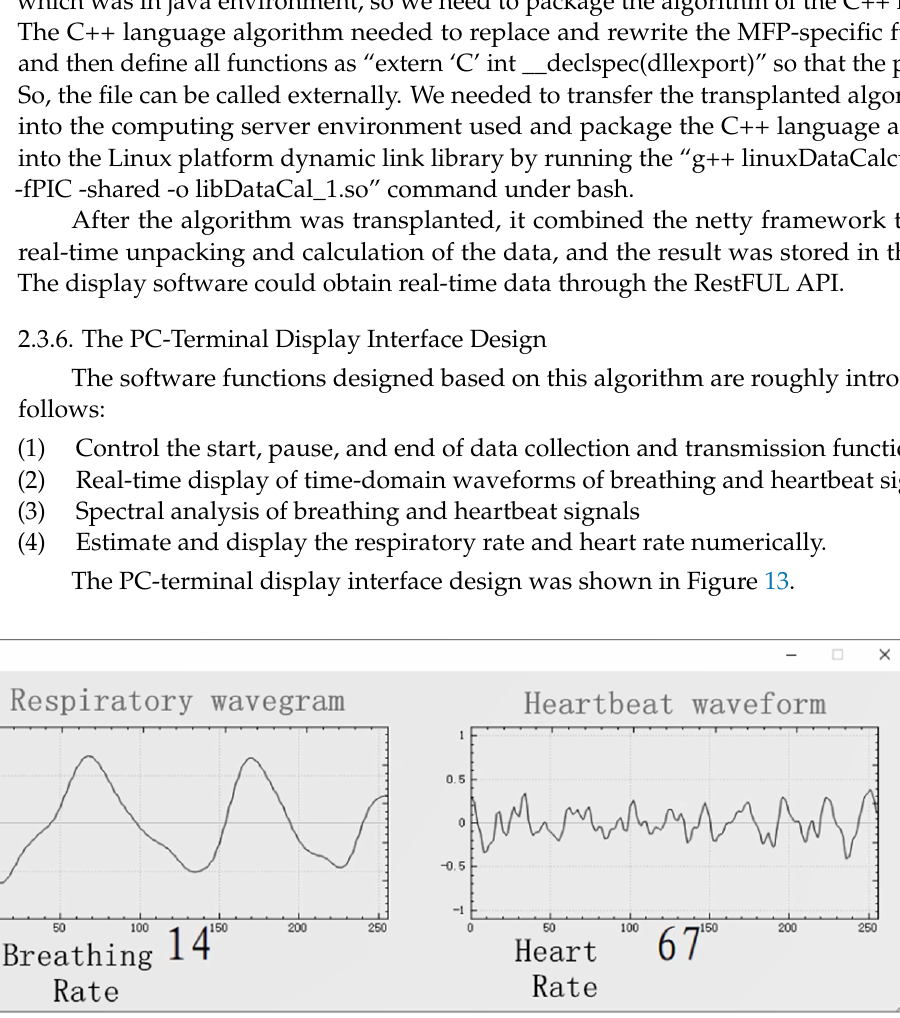
Figure 13. The PC-terminal display interface design.